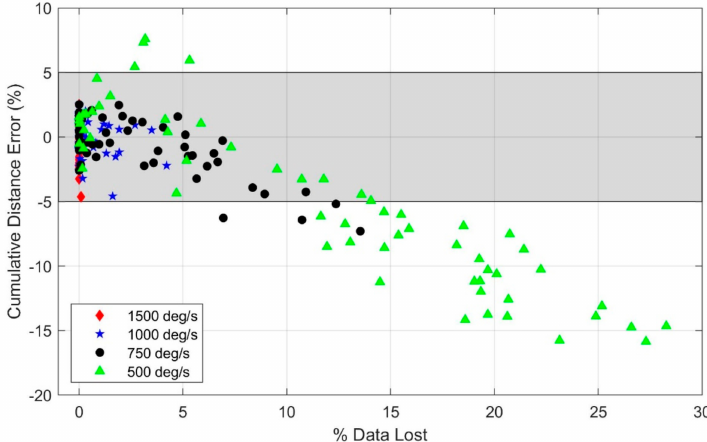
Figure 9. Cumulative distance error versus percentage of angular velocity data lost due to saturation for all trials and for each gyro range. The shaded region indicates estimates within ± 5%